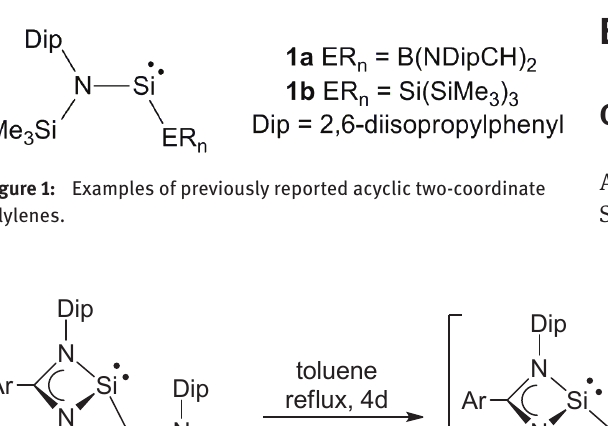
Ar = 4- tert -butylphenyl